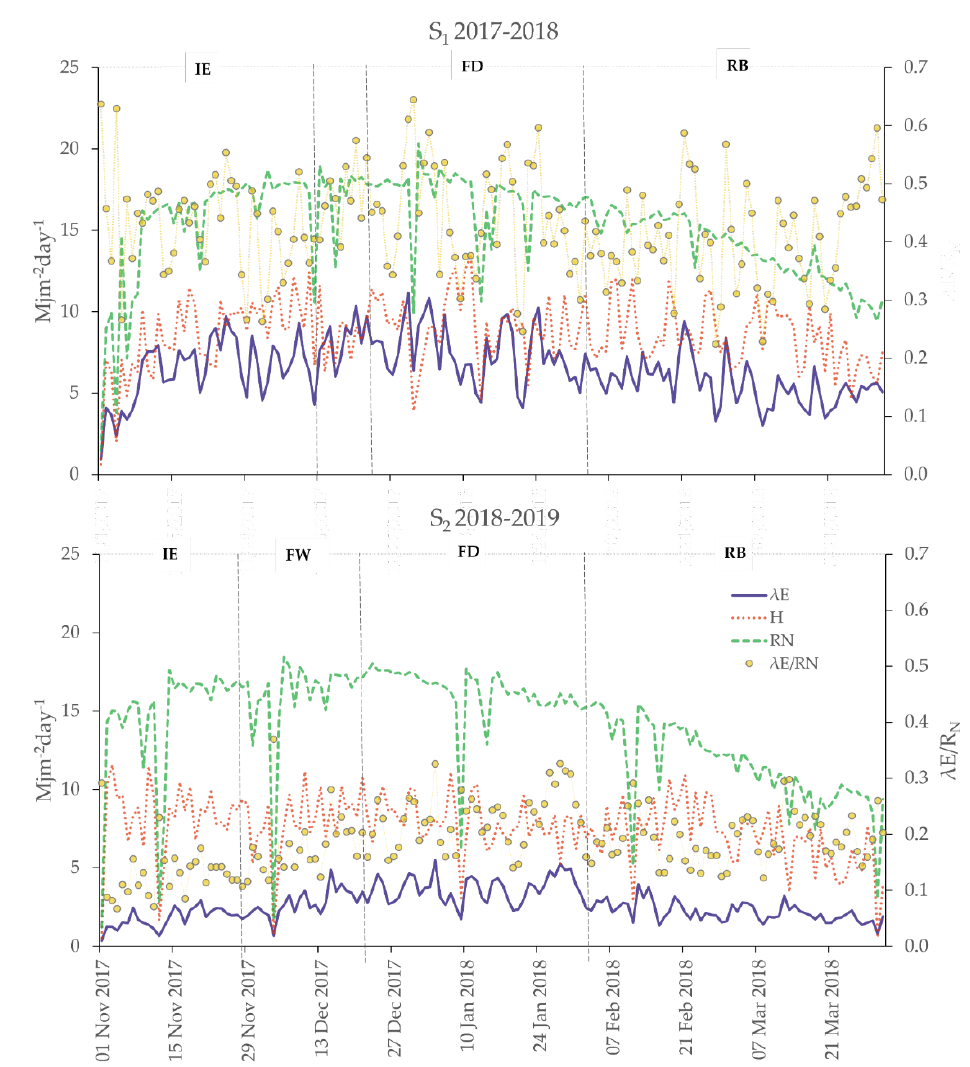
Figure 4. Daily average energy balance components during seasons S 1 (November 2017–March 2018) and S 2 (November 2018–March 2019). Dashed lines indicate the duration of the following phenological phases of the vineyard: LD = Leaf Development (BBCH-11); IE = Inflorescence Emergence (BBCH-53); FW = Flowering (BBCH-61); DF = Development of Fruits (BBCH-71); RB = Ripening of Berries (BBCH-81).